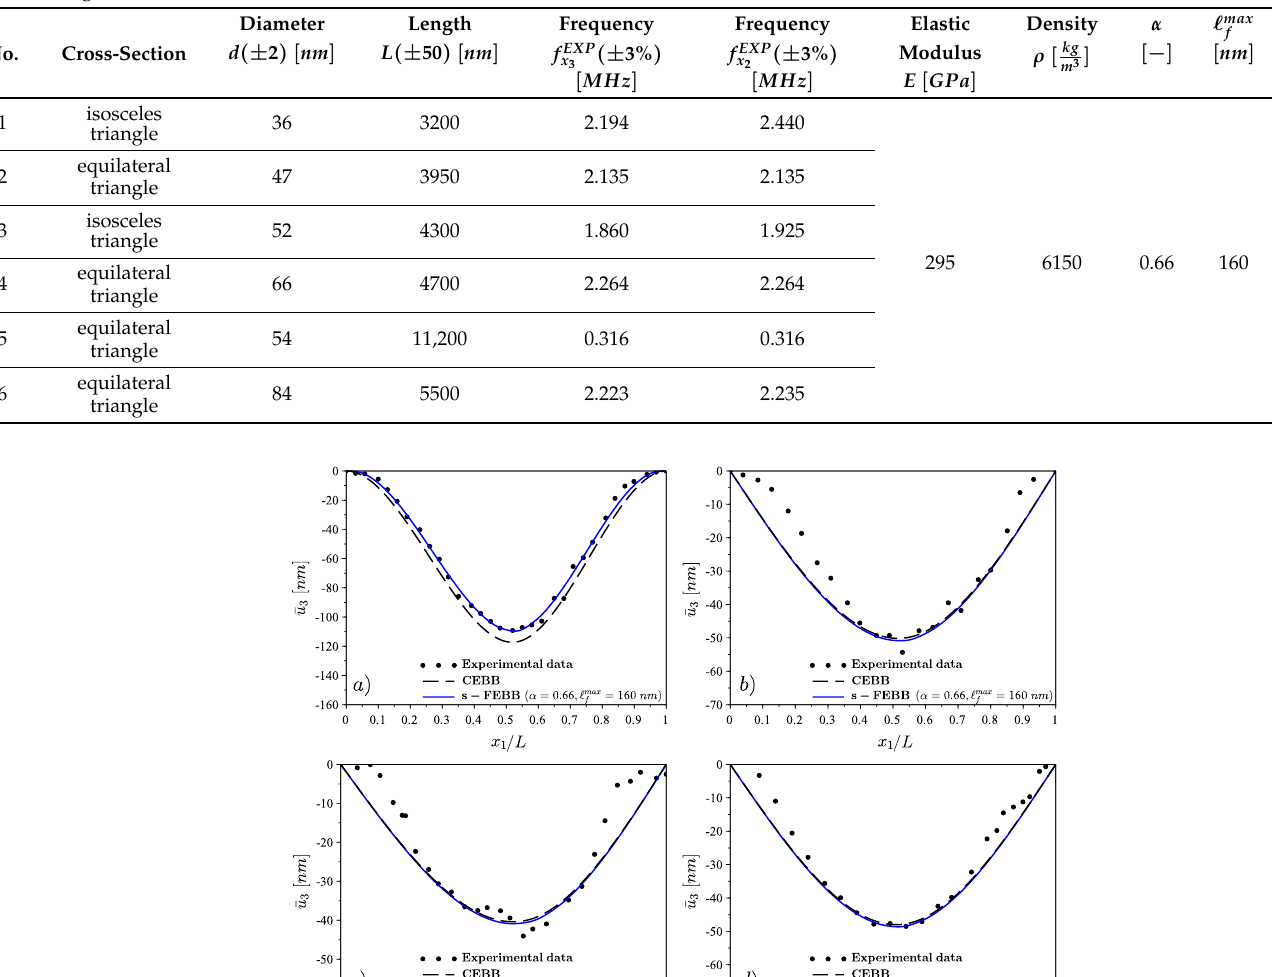
Table 6. Beam dimensions, measured frequencies, and material parameters for GaN nanobeams in resonance test [38] (see also Figure 13).